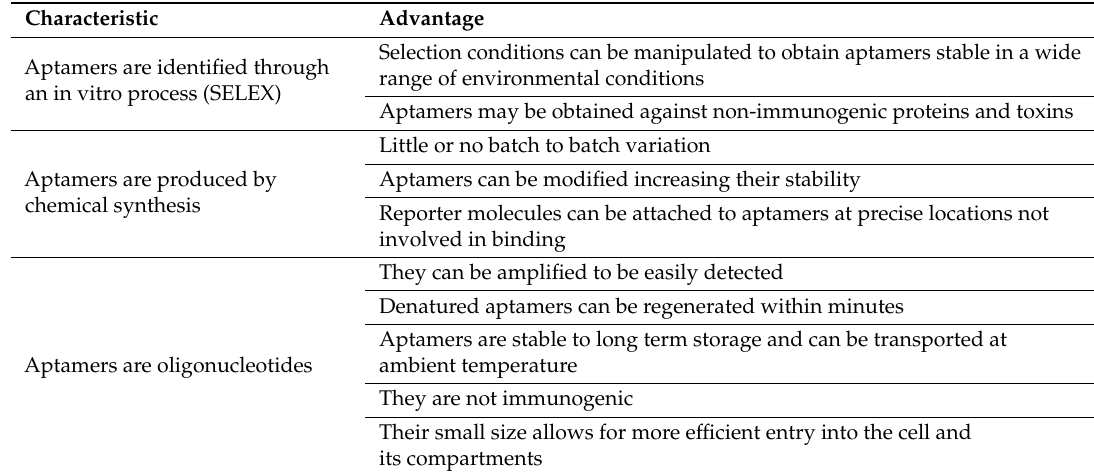
Table 1. Main advantages of aptamers over antibodies.